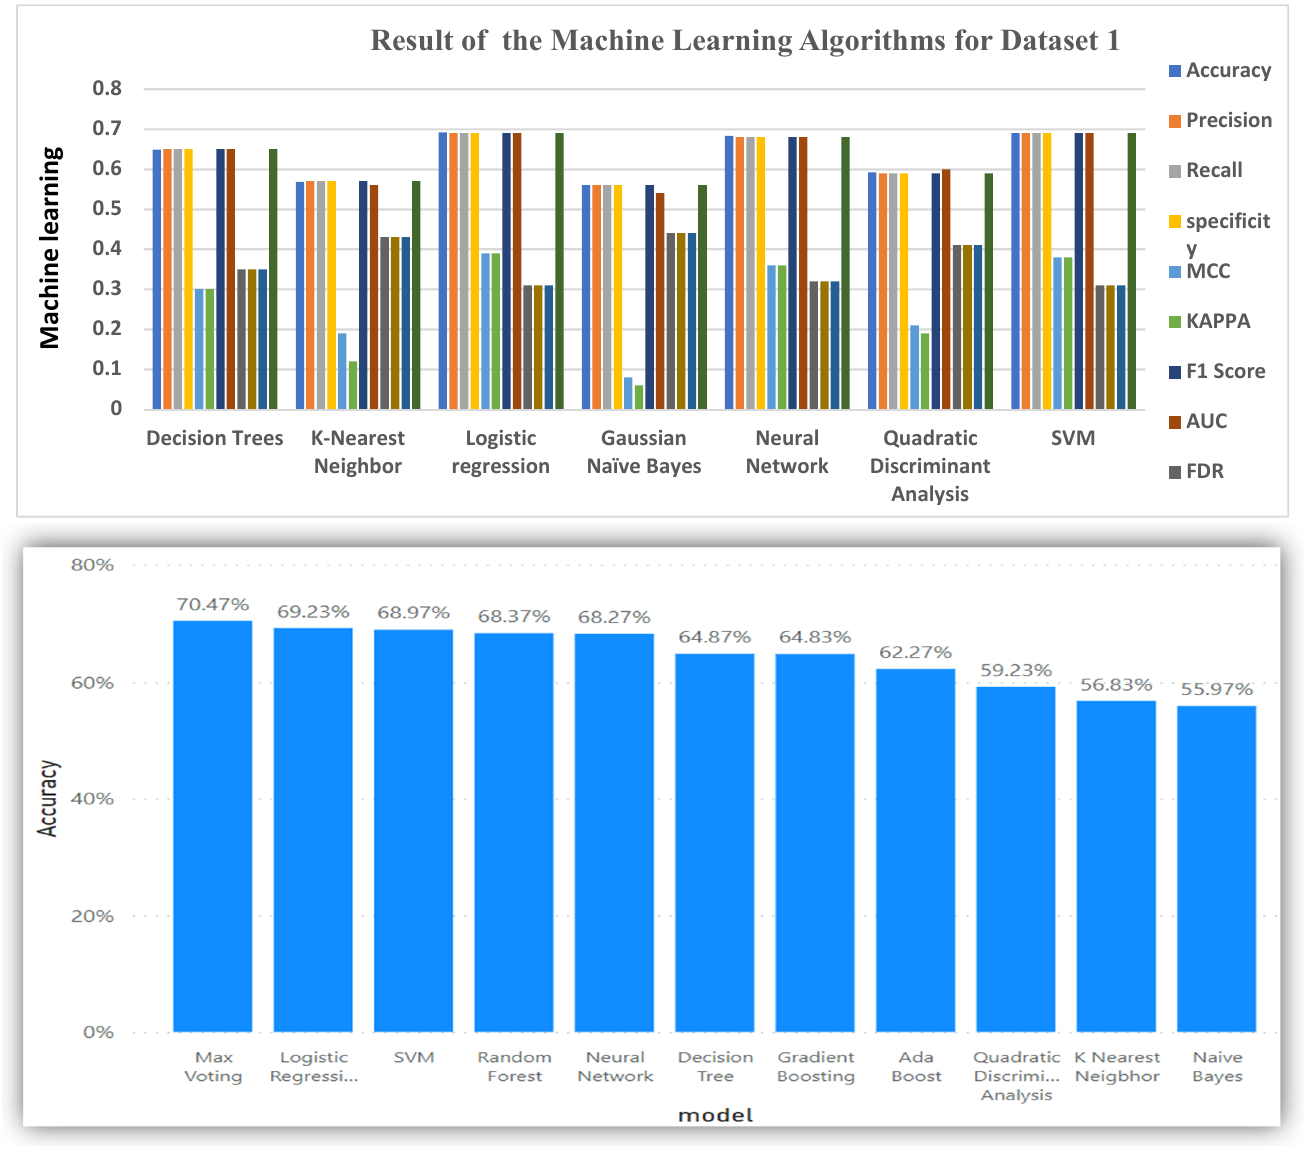
Figure 1. Graphical representations of Evaluation Metrics against Machine Learning Algorithms and ensemble learning for Dataset 1.